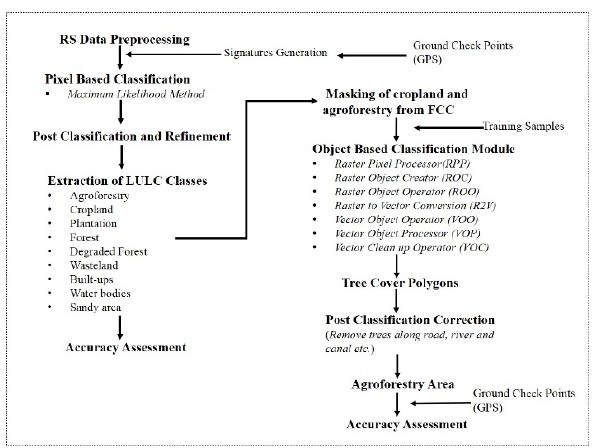
Figure 3. Steps involved in Agroforestry Mapping